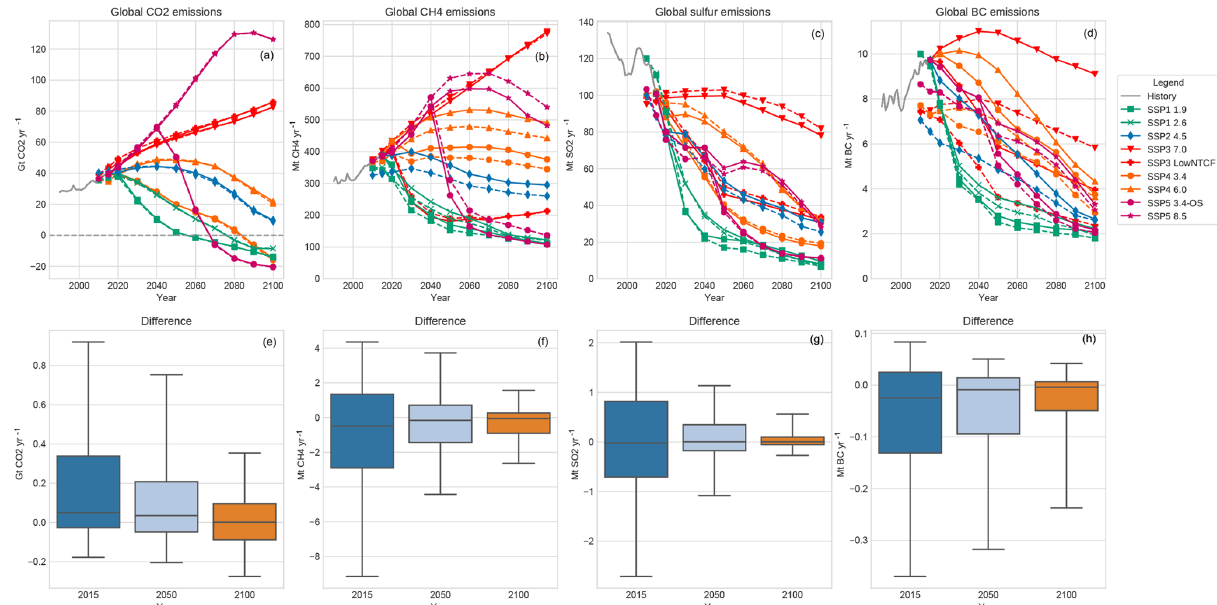
Figure 7. Harmonized (solid) and unharmonized (dashed) trajectories are shown are shown in Panels (a) – (d) . Panels (e) – (h) depict the distribution of differences (harmonized and less unharmonized) for every modeled region. All box plots show upper and lower quartiles as solid boxes, median values as solid lines, and whiskers extending to the 10th and 90th percentiles. Median values for all are near zero; however, the deviation decreases with time as harmonized values begin to more closely match unharmonized model results largely due to the use of convergence